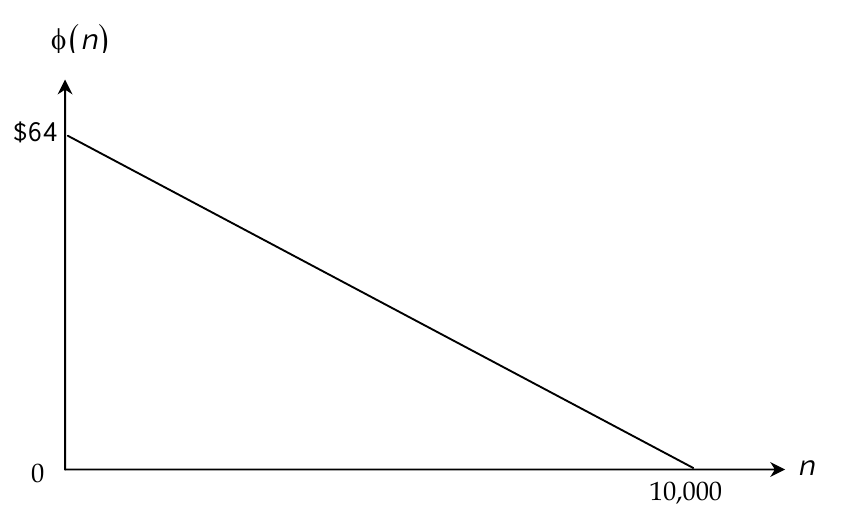
Figure 7. The location dependent parking fees in regime o